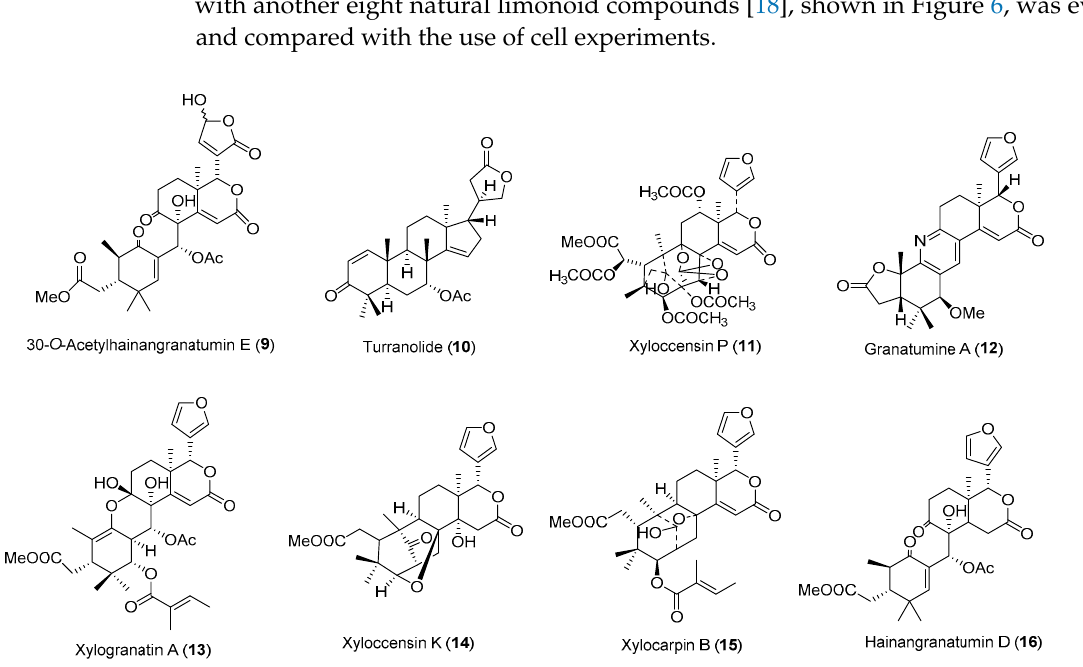
Table 1. Experiment results of anti-inflammatory activity screening of limonoids.